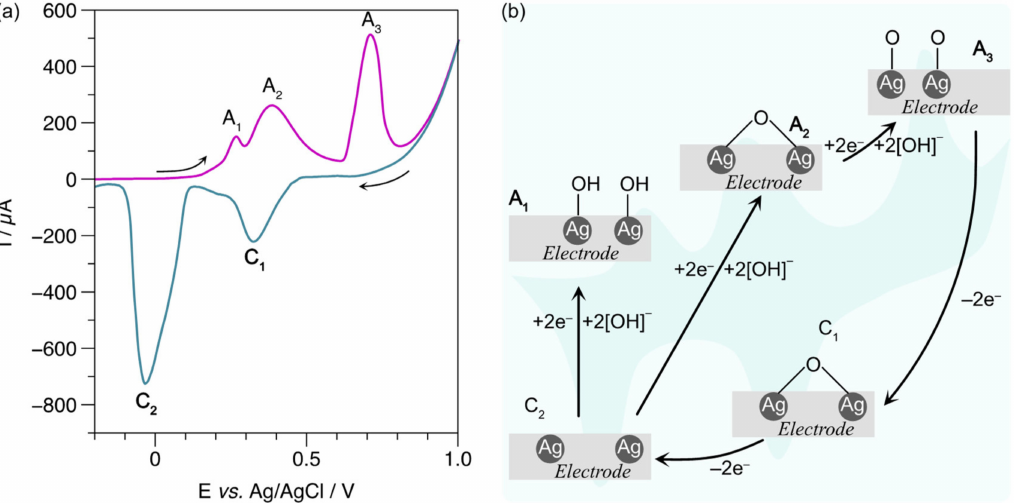
Figure 6. ( a ) CV of LIG/AgNPs in the presence of NaOH electrolyte; ( b ) schematic representation of Ag oxidation states in NaOH electrolyte.